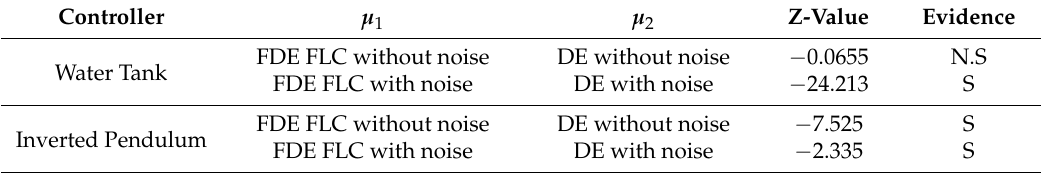
Table 16. Results for the statistical test with Fuzzy differential evolution